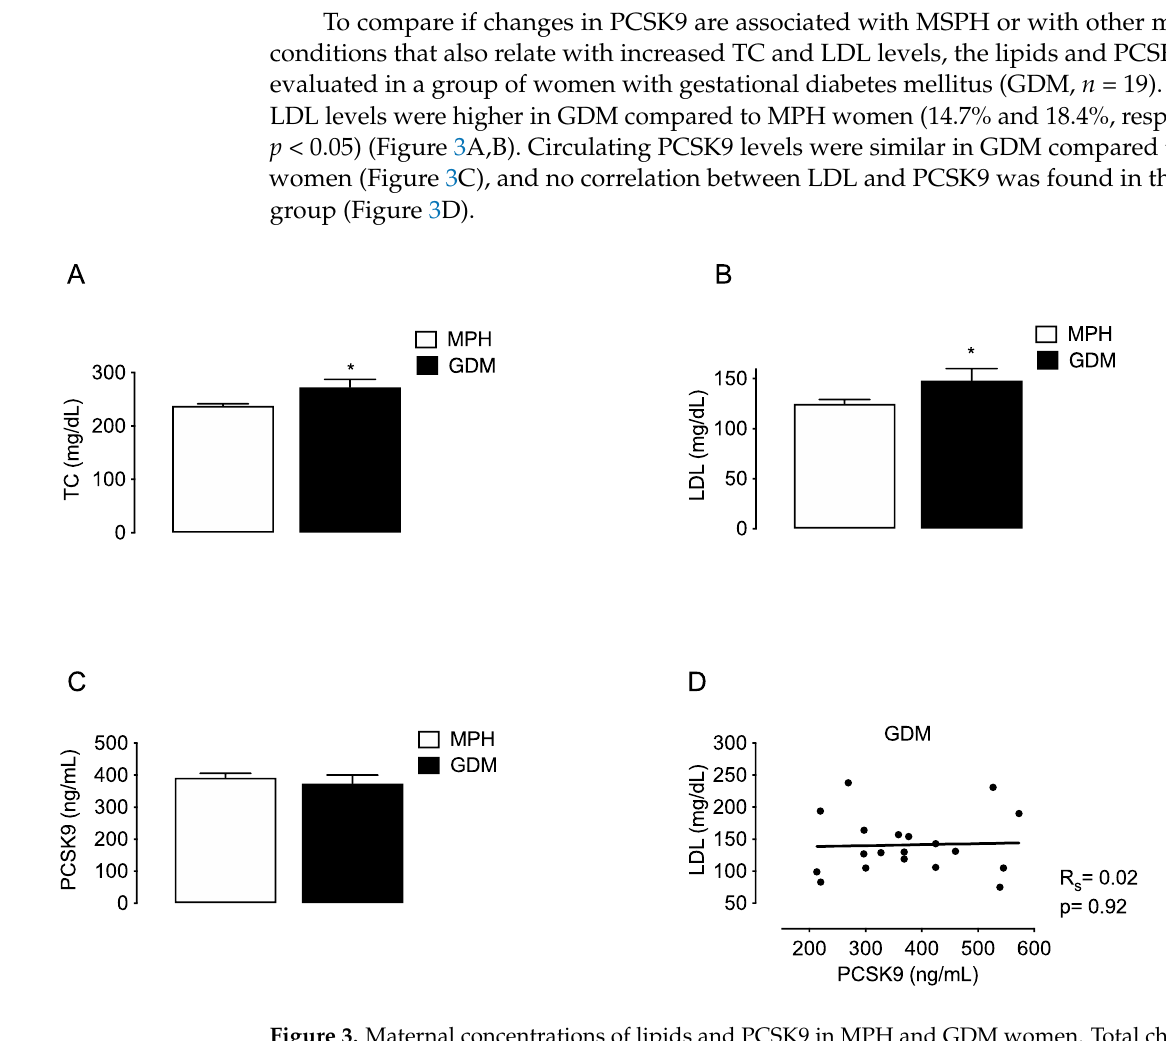
Figure 3. Maternal concentrations of lipids and PCSK9 in MPH and GDM women. Total cholesterol (TC, ( A )), LDL ( B ), HDL ( C ) and circulating levels PCSK9 ( C ) were determined in serum from MPH women ( n = 44, white) and women with gestational diabetes mellitus women at T3 (GDM, n = 19, black). ( D ) Spearman’s correlation (R s ) between LDL and PCSK9 levels in the the GDM group. Values are mean ± S.E.M. * p < 0.05 versus values for MPH. LDLs were isolated from MPH and MSPH serum ( n = 7 per group) and equal protein mass was separated by electrophoresis. The protein abundance of ApoE and ApoAII was comparable between groups (Figure 4A). However, the levels of ApoB were higher in LDL from MSPH women ( p < 0.05) (Figure 4A). Although the levels of ApoAI were significatively lower in LDL compared to HDL after ultracentifugation (data not shown), the protein was quantifiable in LDL. Figure 4A shows that the protein abundance of ApoAI was reduced in LDL from MSPH women compared to MPH ( p < 0.05) (Figure 4A). In addition, the levels of triglycerides and cholesterol (total, free and ester) were determined in LDL isolated from MPH and MSPH women. In LDL from MSPH, the levels of triglycerides were 43% higher compared to MPH ( p < 0.05) (Figure 4B). No changes in cholesterol levels were determined (Figure